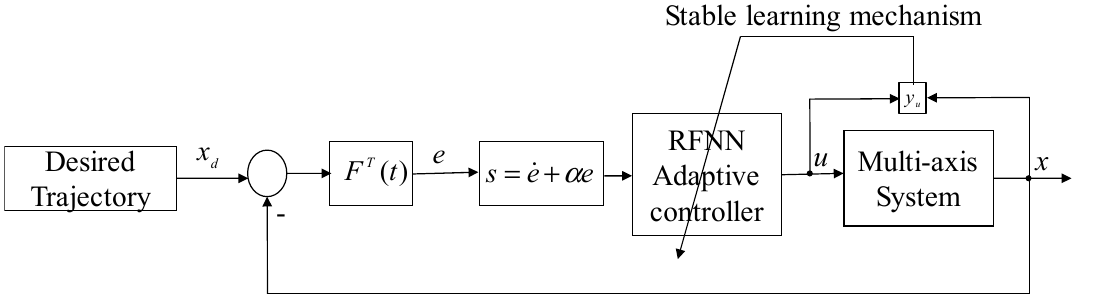
Figure 3. The configuration of the proposed recurrent fuzzy neural network (RFNN) [21].